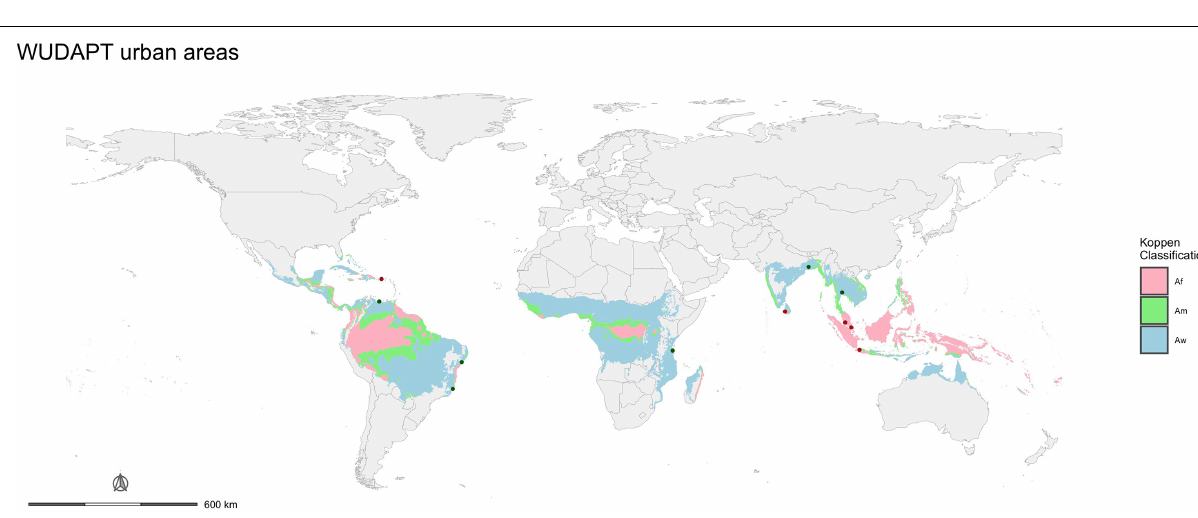
concordance with the observed spatial pattern (Buyantuyev et